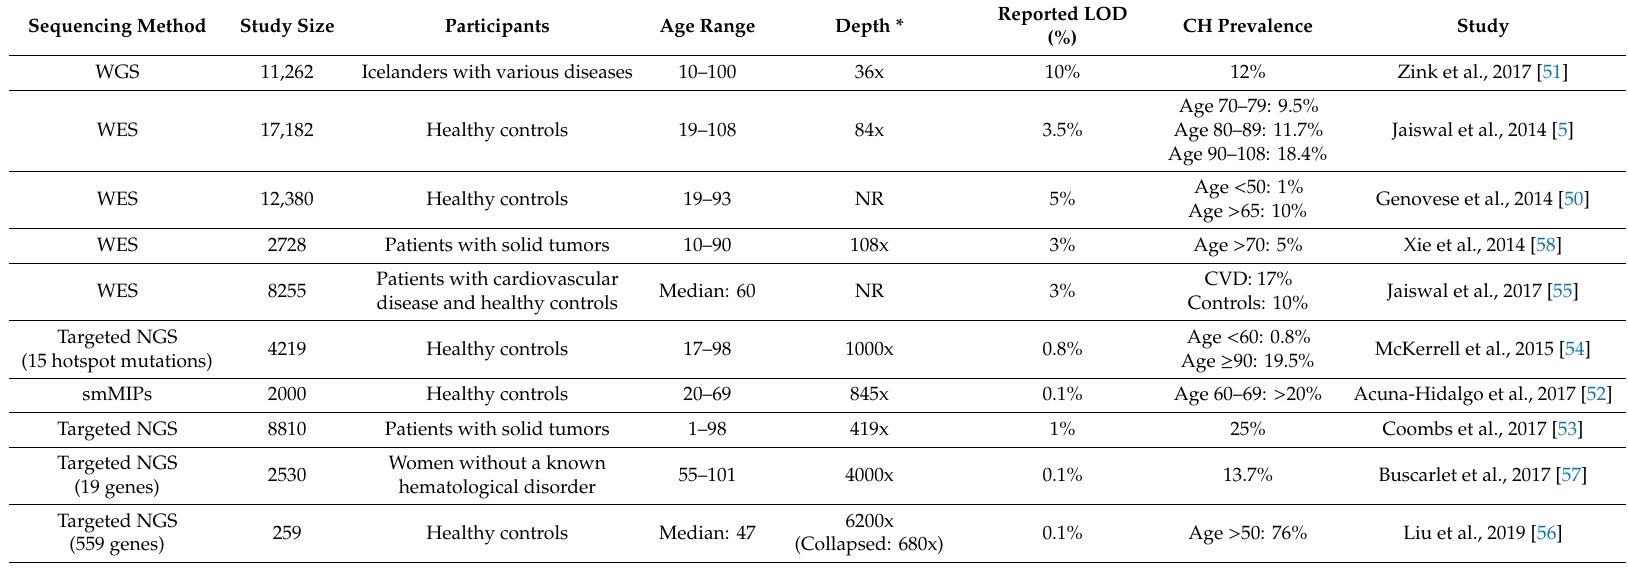
Table 1. Summary of published studies on the prevalence of clonal hematopoiesis (CH) mutations in individuals without known hematological malignancies. Sequencing